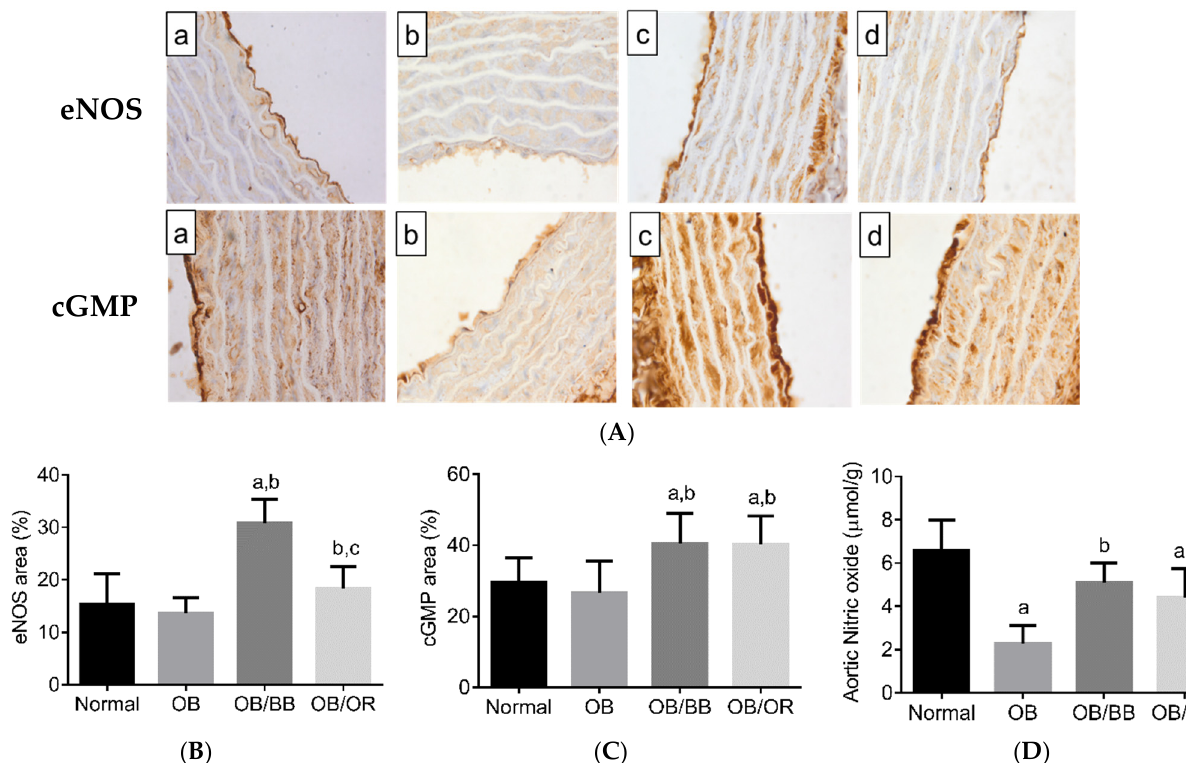
Figure 3. Representative photomicrographs from positive immunohistochemical staining of ( A,B ) eNOS and ( A,C ) cGMP area (brown staining, magnification 400×), and ( D ) aortic NO level in the aorta of ( a ) normal ( b ) OB ( c ) OB/BB and ( d ) OB/OR groups, n = 6/group. The quantitative positive staining area of eNOS and cGMP are shown in ( B ) and ( C ), respectively and expressed in percentage value. All data are presented as mean and standard deviation. a p < 0.05 compared to normal group, b p < 0.05 compared to the OB group, c p < 0.05 compared to the OB/BB group. All data were analyzed using one-way ANOVA followed by Tukey’s post hoc test. OB: obese, OB/BB: obese and bee bread 0.5 g/kg/day, OB/OR: obese and orlistat 10 mg/kg/day, eNOS: endothelial nitric oxide synthase, cGMP: cyclic guanosine monophosphate, NO: nitric oxide.